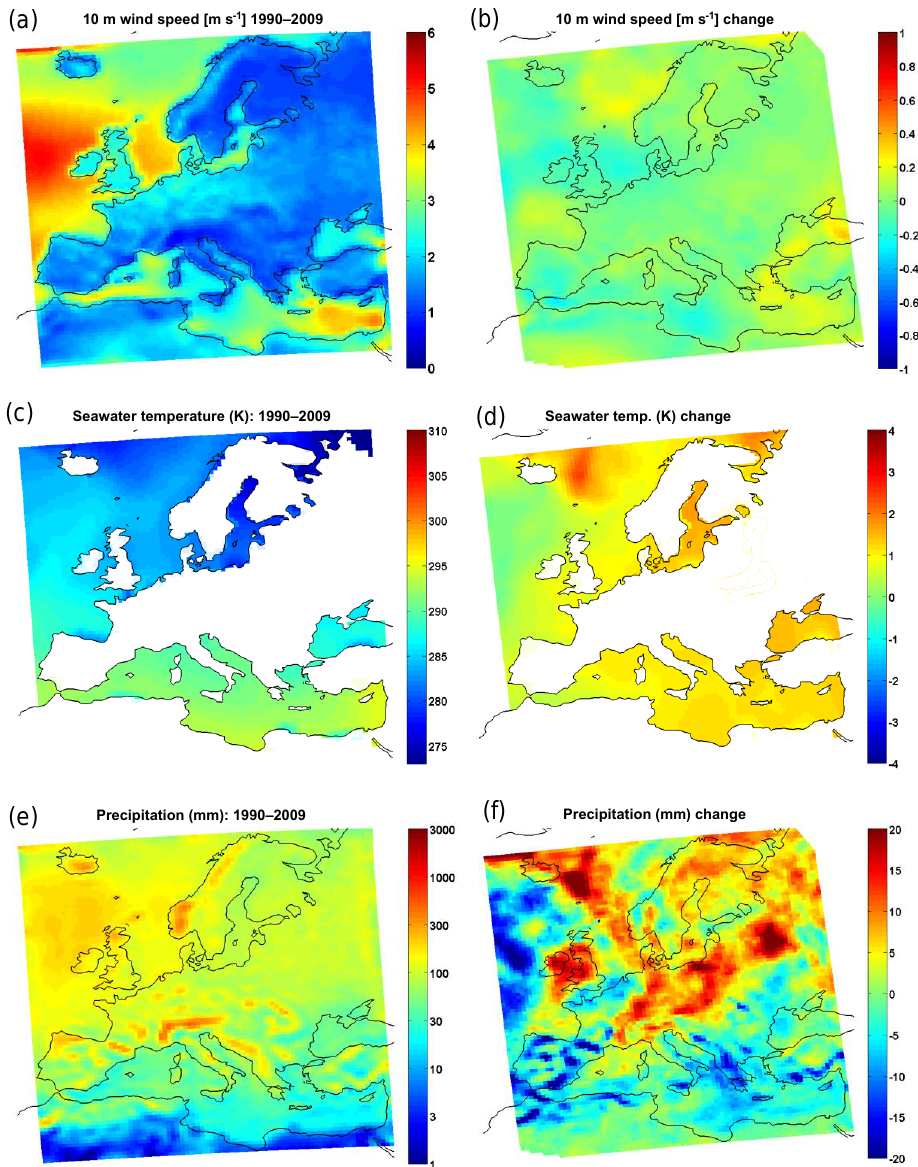
Figure 1. (a, b) Wind speed (ms − 1 ); (c, d) sea surface temperature (K); (e, f) precipitation (mm). Left panels: mean value for the past period (1990–2009); right panels: absolute difference between the future (2040–2059) and past periods.